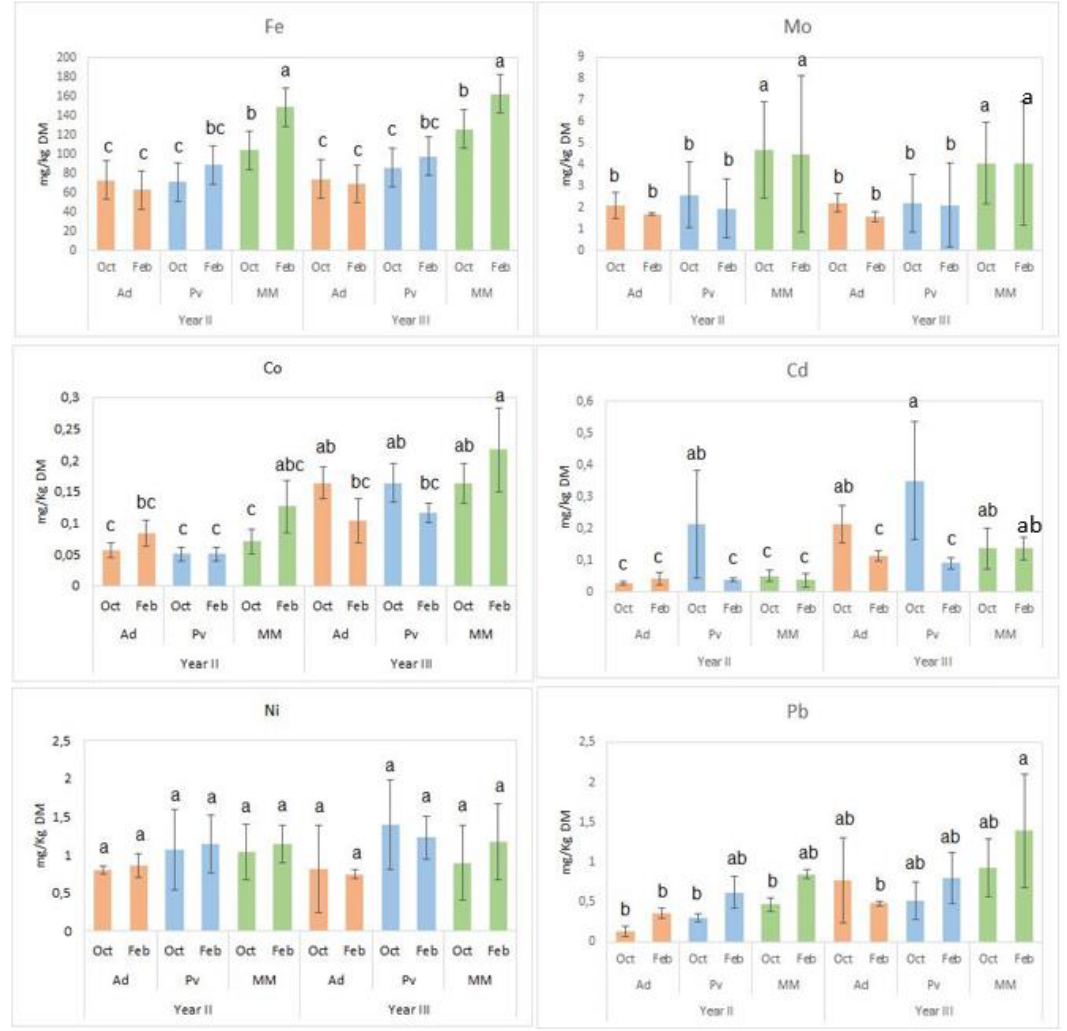
Figure 4. Accumulation of heavy metals in the harvested biomasses of the second and third years, separated into subgroups by Tukey HSD test. For Mn and Mo, groups were separated by species (S); for Al, Cr, Fe, Cu and Zn homogeneous groups were distinguished by species (S) and harvest time (HT); for Co, Cd and Pb, groups considered S, HT and year (Y) factors. Bars represent SD.